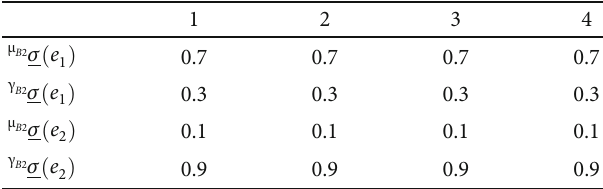
Table 33: Lower approximation of B .